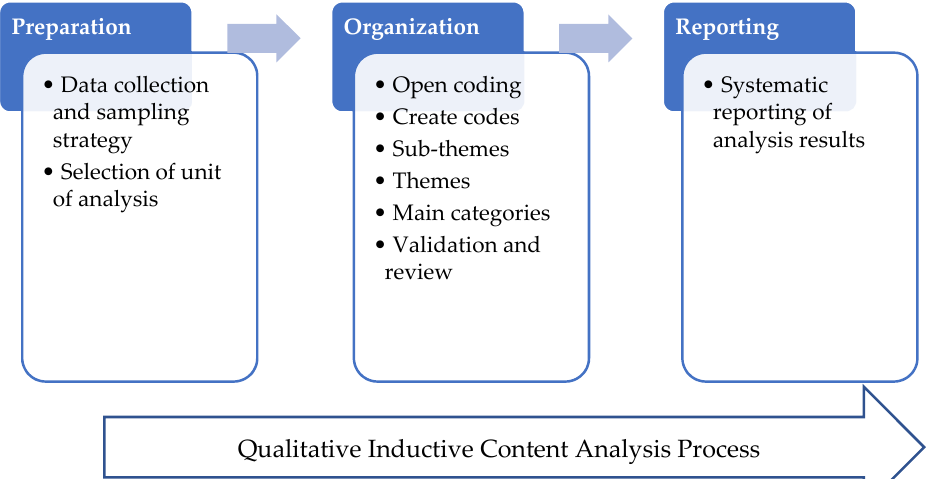
Figure 2. Step-by-step Procedure of Qualitative Inductive Content Analysis.